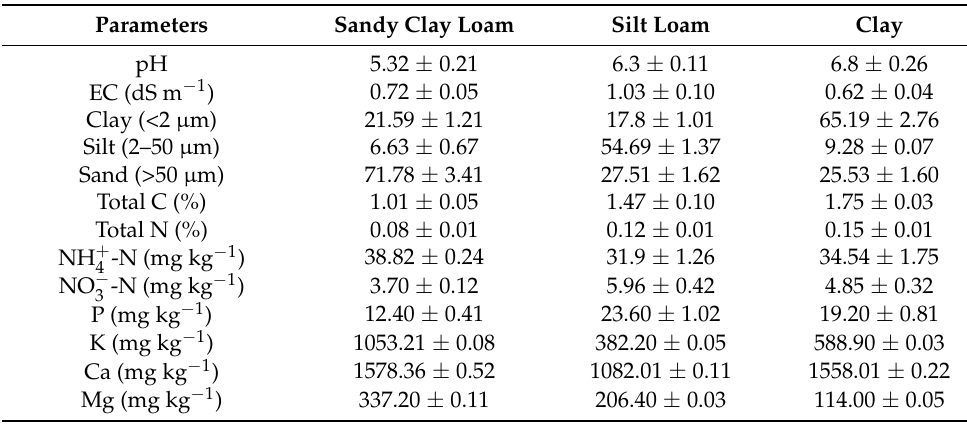
Table 2. Initial mean ( ± SE) physicochemical properties of the three soils used in this study.